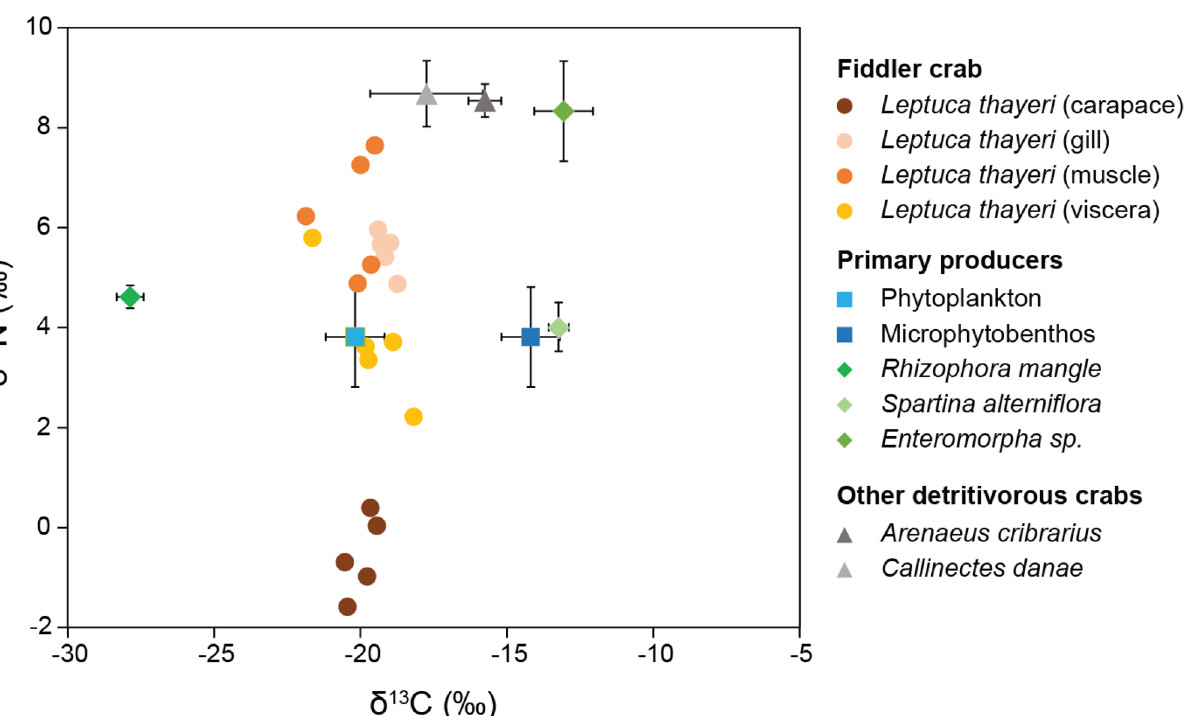
Figure 4. Signature of N 2 fixation in crab’s carapace biofilms stable isotope ratios: biplot of the natural abundance of 13 C and 15 N isotopes for different samples (carapace, gill, muscle, viscera) from the fiddler crab ( Leptuca thayeri , n = 5), and for different primary producers (as potential sources of detritus) and other detritivores crab species from the Cananéia estuarine system (data from Nagata et al. 40